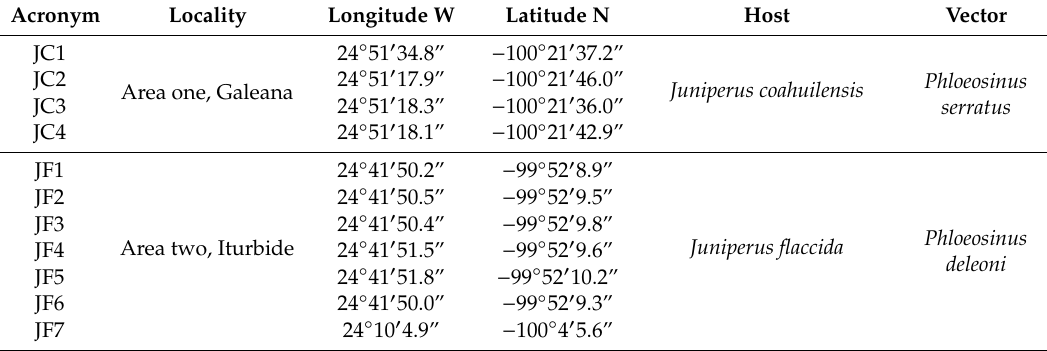
Figure 1. Map of sampling sites of Geosmithia spp. in Nuevo León, México. Acronyms of samples in Table 1. Table 1. Sample acronym of freshly cut branches of Juniper species, locality, host species, and bark beetle species vector, studied in Nuevo León State, Mexico.